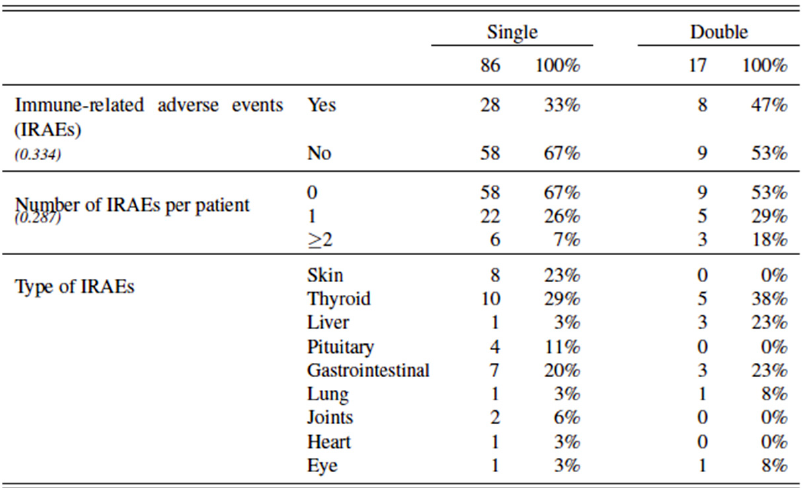
Figure 4. Immune-related adverse events in all included patients with advanced melanoma treated with single versus double ICI.